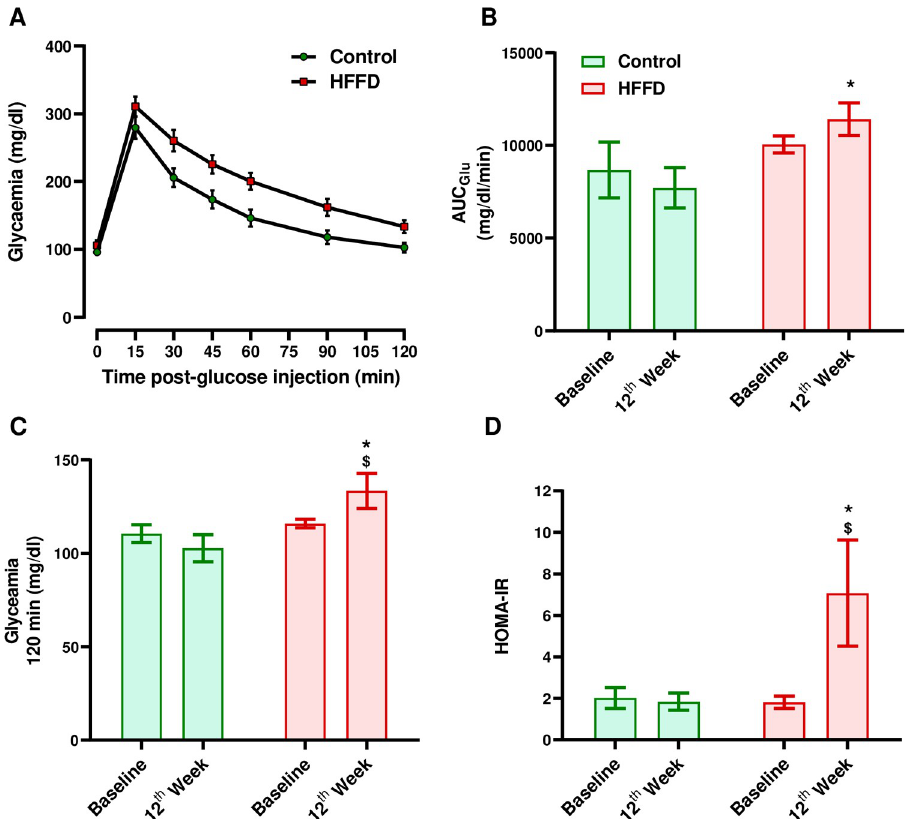
Fig 1. Effect of HFFD feeding on glucose and insulin metabolism. Glucose metabolism was evaluated by: (A) an IVGTT, performed after 12 weeks of HFFD feeding. As described in the method, at the end of the protocol, rabbits were intravenously injected with a glucose bolus, then plasma (B) glucose and were evaluated. (B) The AUC curve from the IVGTT was calculated to compare the differences between the two groups. (C) Changes in plasma glucose levels 2 hours after the bolus were determined. (D) Insulin metabolism was assessed by calculating the Homeostasis model assessment of insulin resistance (HOMA-IR). Data were expressed as the mean ± SEM. �� p < 0.01 or � p < 0.05 HFFD vs. control group. $ $ p < 0.01 or $ p < 0.05 12th week vs. baseline (n = 9 for control and n = 12 for